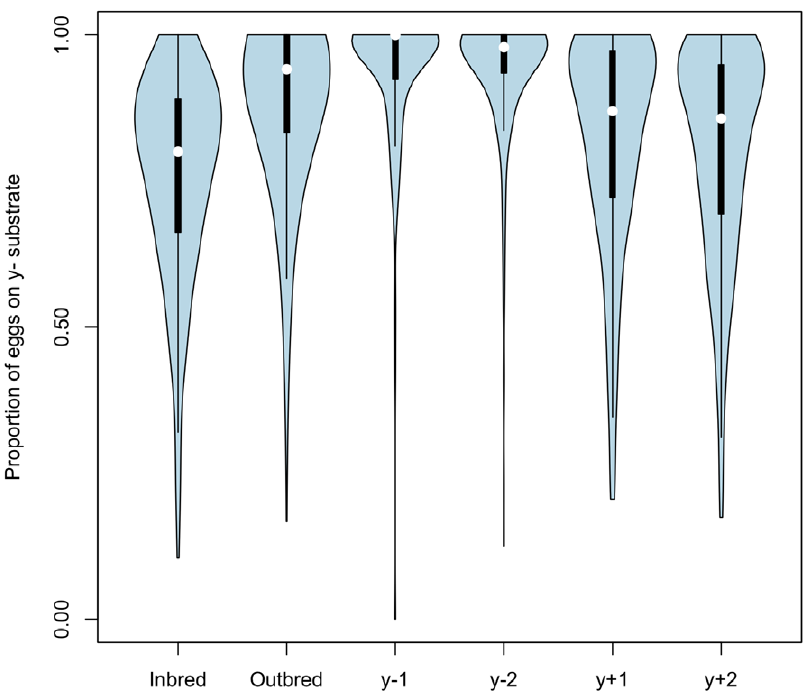
Figure 3. Violin plots of preference behavior. Each element contains a Tukey box plot showing the median (white dot), 75% quartile (thick line) and range excluding outliers (thin line). Surrounding the box plot is a kernel density trace, plotted symmetrically on both sides of the boxplot, which provides a graphical comparison of each distribution (following [34]). Inbred = distribution of inbred RAL genotypes; Outbred = the F 8 population started from these inbred lines; y-1 and y-2= populations selected for a single generation in the direction of 1.00; y + 1 and y + 2= populations after two generations of selection in the direction of 0.00.